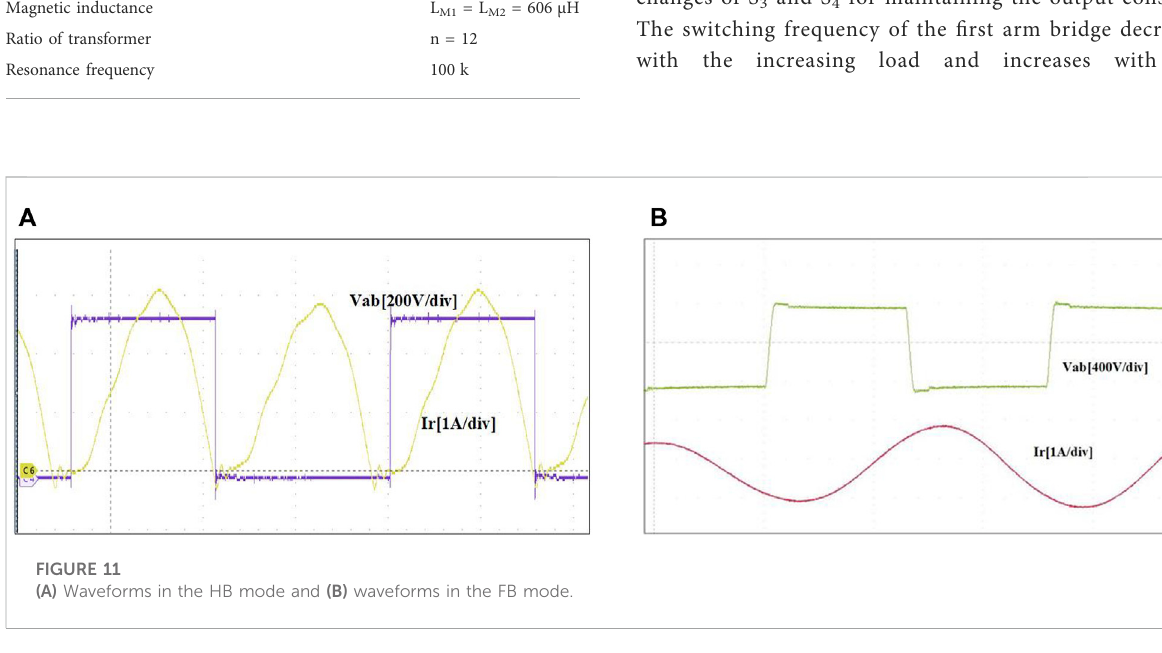
complementary to ensure that the circuit is running correctly, as shown in Figure 8. During transition, the switching frequencies of S 1 and S 2 continue to be regulated by the PI controller. The switching frequencies of S 1 and S 2 are adjusted without considering the duty cycle changes of S 3 and S 4 for maintaining the output constant. with the increasing load and increases with the